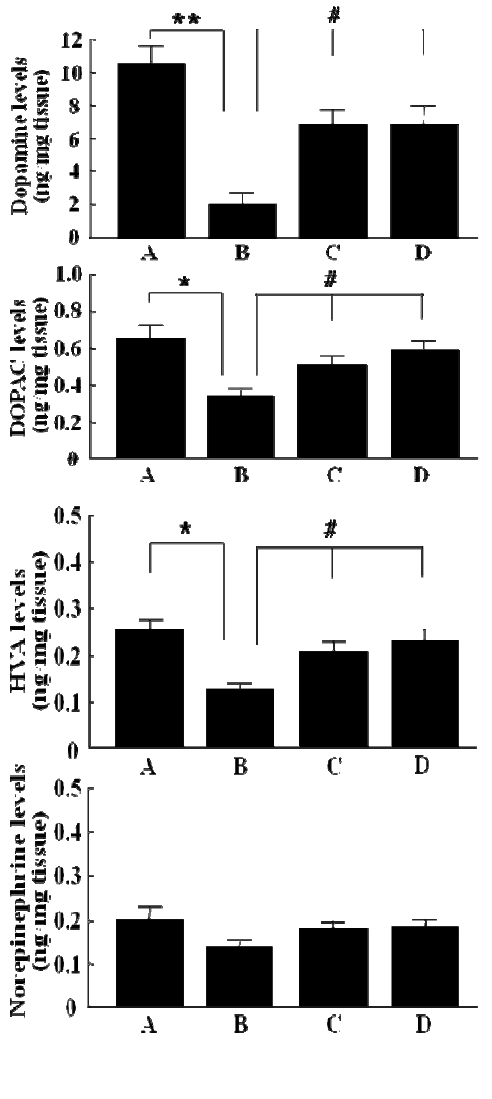
Figure 3. Effects of GP-EX on the levels of dopamine, DOPAC, HVA and norepinephrine in the striatum of 6-OHDA-lesioned rats. GP-EX (10 and 30 mg/kg) was administered orally to 6-OHDA-lesioned rats from day 3 post-lesion for 28 days. The levels of dopamine, DOPAC, HVA and norepinephrine in the striatum were determined by HPLC method. Results are represented as means ± S.E.M of four experiments. Sham-lesioned groups (A), 6-OHDA-lesioned groups (B), GP-EX-administered groups [10 mg/kg (C) and 30 mg/kg (D)] in 6-OHDA-lesioned rats. * p < 0.05 compared with sham groups; # p < 0.05 compared with 6-OHDA-lesioned groups (ANOVA followed by Tukey’s